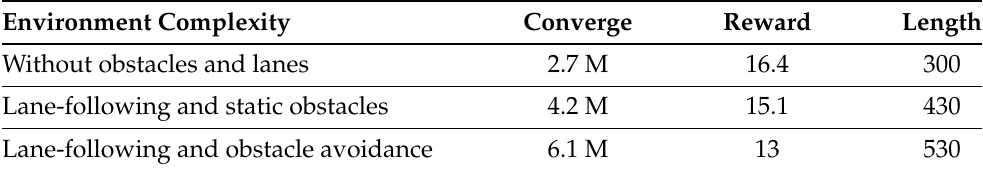
Table 3. Mean of the accumulated rewards and convergence speed for different scenarios.